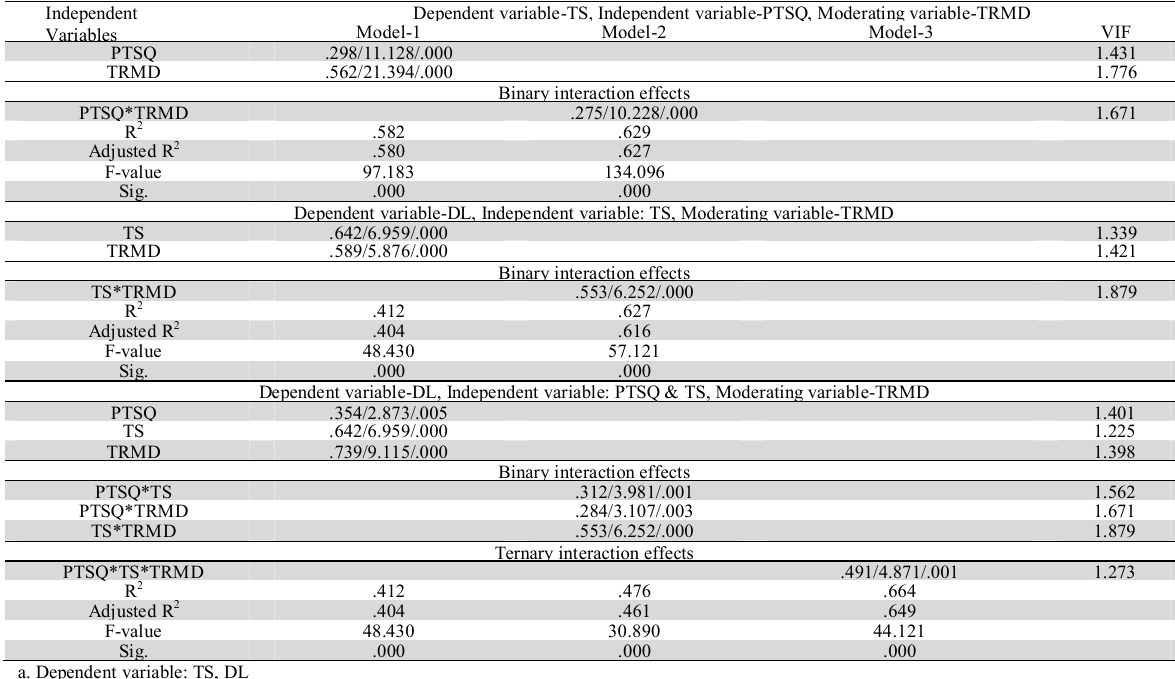
Hierarchical regression results Independent Variables